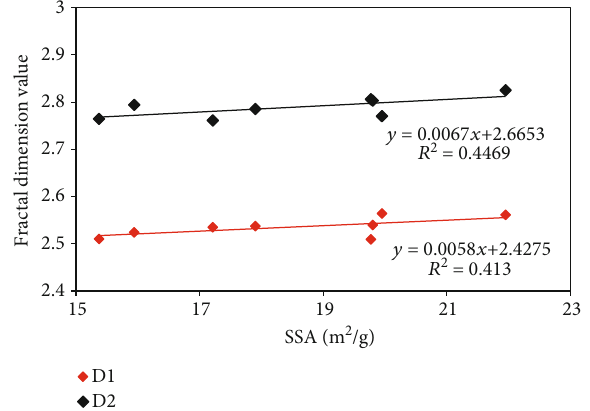
Figure 10: Relationship between fractal dimensions and slick water soaking